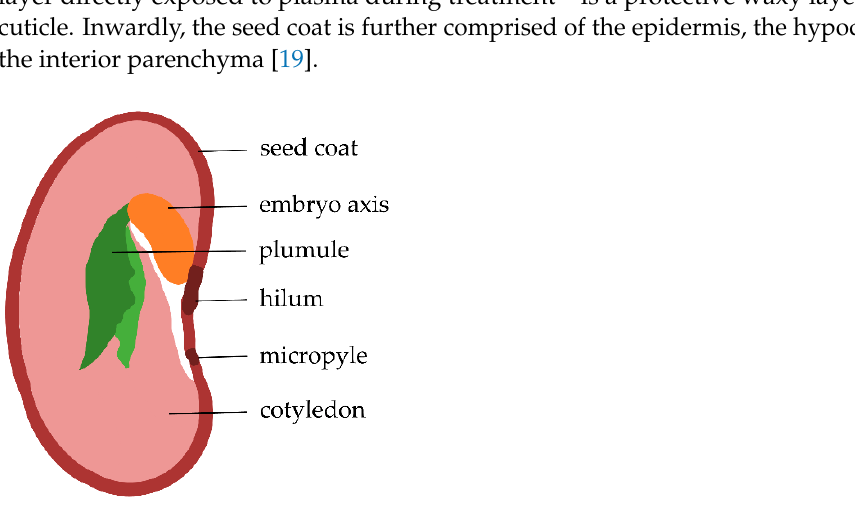
Figure 1. Schematic cross-section of a bean seed. Adapted from [20].